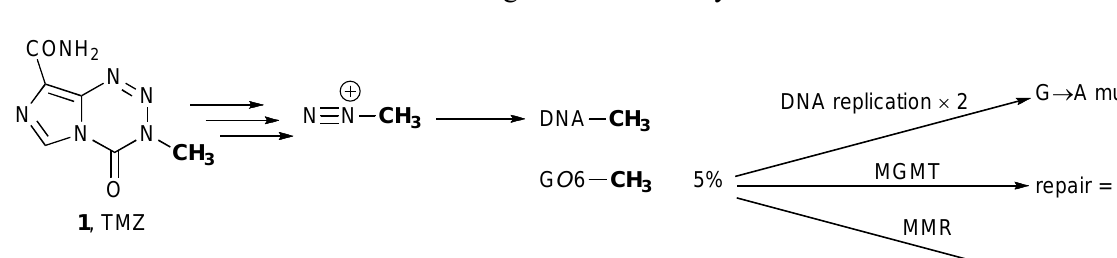
Scheme 2. Biological fate of methyldiazonium ions.